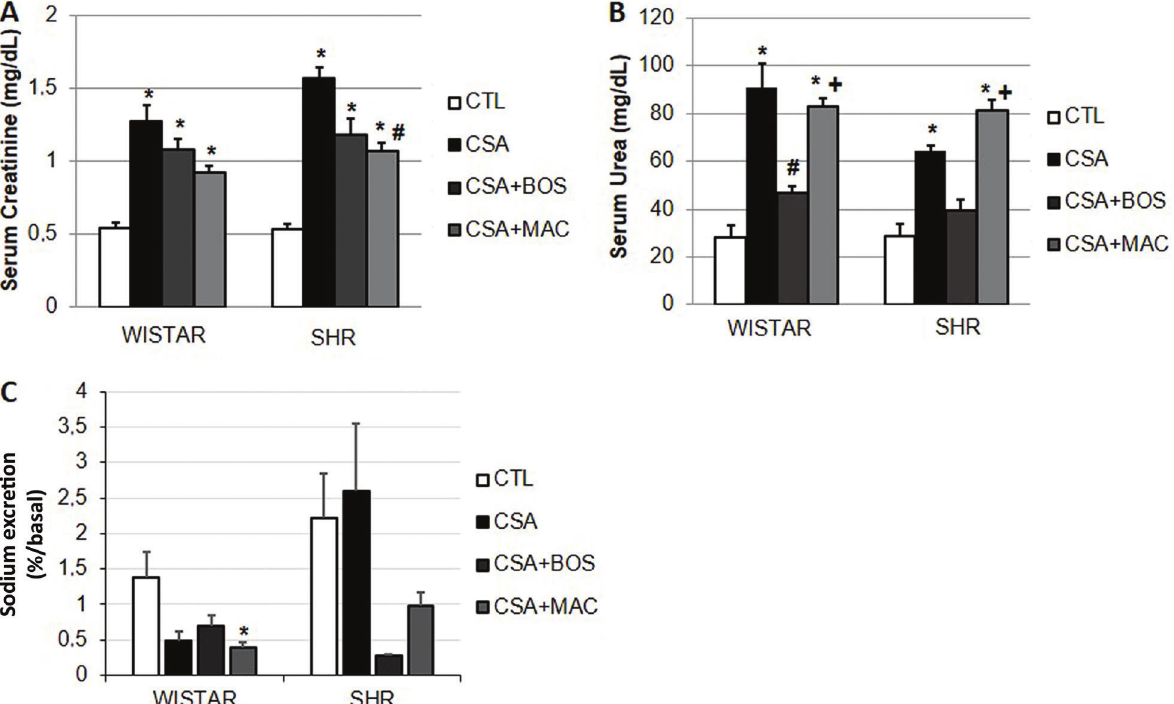
Figure 3. Quantitative analyses of A , plasmatic creatinine, B , plasmatic urea, and C , sodium excretions in Wistar (normotensive) and genetically hypertensive (SHR) rats in the control group (CTL), receiving cyclosporine-A (CsA) or receiving CsA and treated with bosentan (CsA + BOS) or macitentan (CsA + MAC) for 15 days. Data are reported as means ± SE. The signi fi cance level for a null hypothesis was set at 5% (P o 0.05). *P o 0.05, compared to the CTL group; # P o 0.05, compared to the CsA group. + P o 0.05, compared to the CsA + BOS group (ANOVA followed by the Tukey test or Student ’ s t